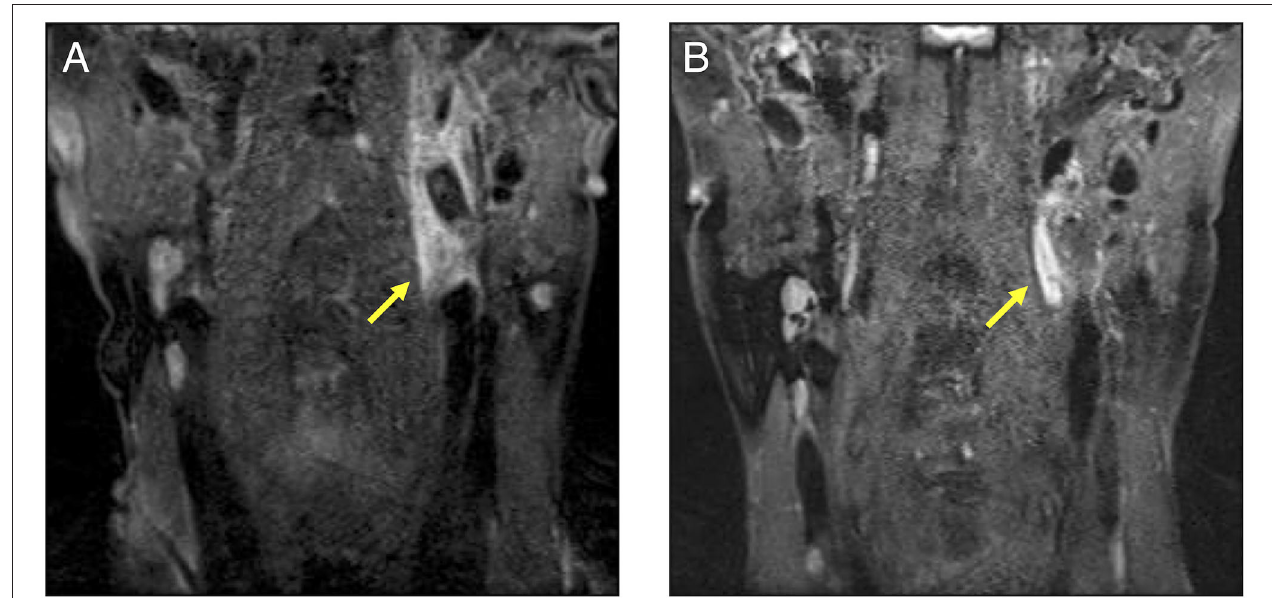
FIGURE 2 | A cervical contrast-enhanced MRI comparison before and after the treatment in our patient. (A) : This MRI was performed before treatment. Aneurysm, stenosis, and dissections were observed in the left internal carotid artery indicated by the arrow. A contrast effect was also observed around the lesion. (B) : The participant underwent MRI as an outpatient after treatment. The contrast effect around the left internal carotid artery had decreased. MRI, magnetic resonance imaging.